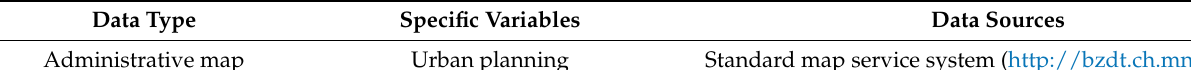
Figure 1. Study area. Table 1. Data sources (accessed on 2 September 2021).